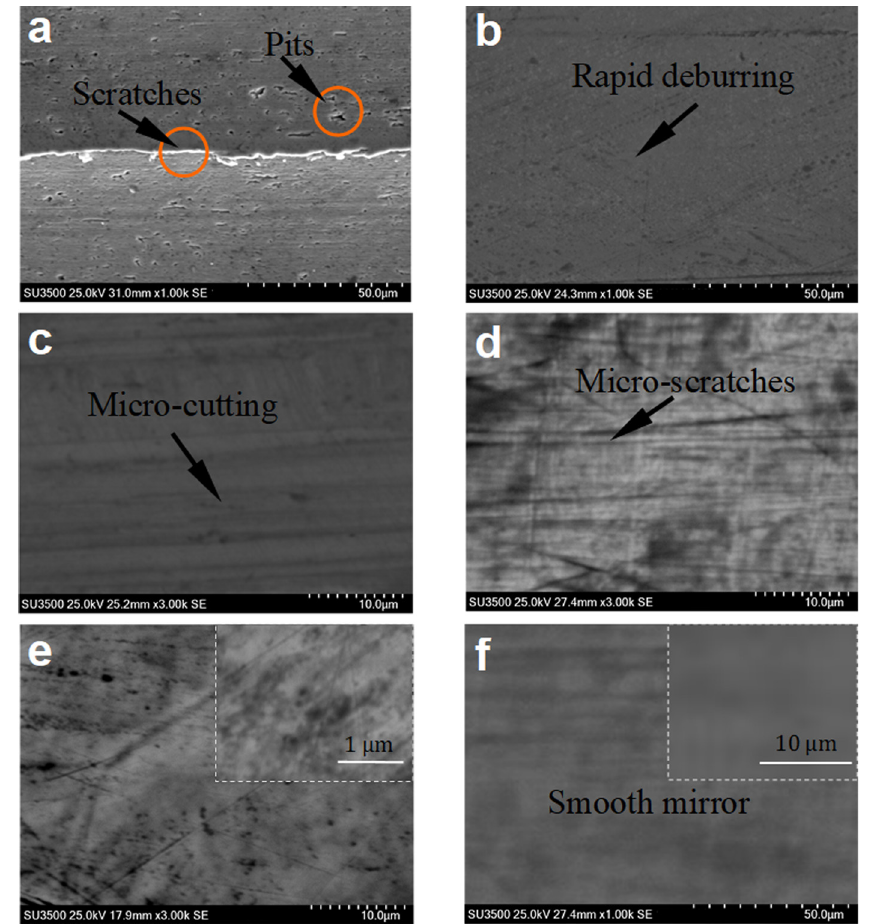
Figure 5: Surface micromorphology: ( a ) unpolished rough surface with scratches ( 0 h ) ; ( b ) rapid deburring ( 0.5 h ) ; ( c ) micro - cutting ( 1 h ) ; ( d ) generation of micro - scratches ( 1.5 h ) ; ( e ) surface fl attening ( 2 h ) ; and ( f ) polished smooth mirror ( 2.5 h ) .